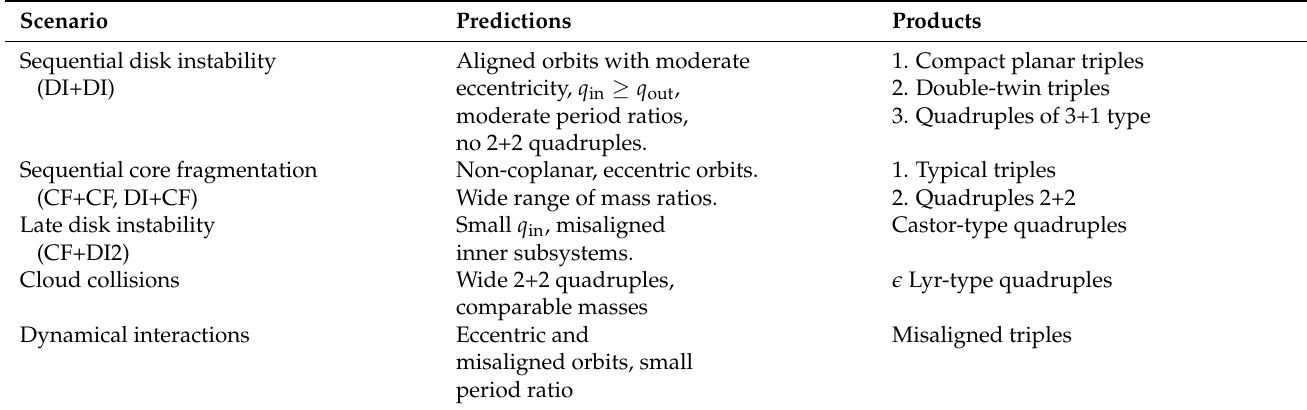
Table 1. Formation